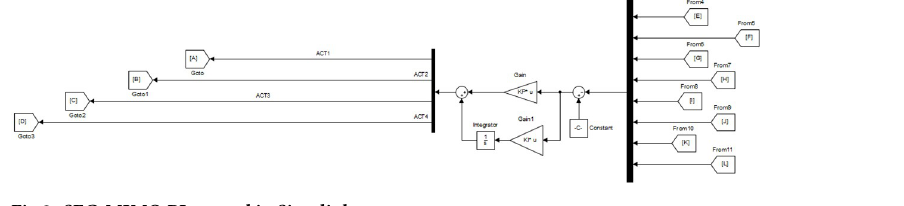
Fig 9. SFG-MIMO PI control in